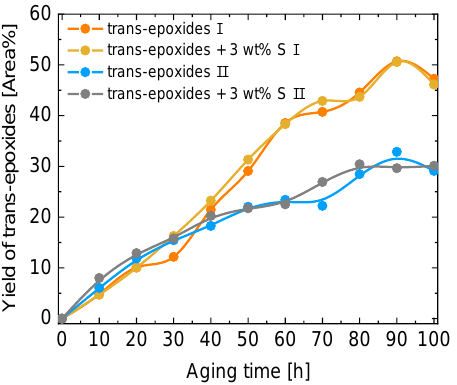
Figure 11. GC–MS measurement to record the yield of trans-epoxide while aging the blends over time. On the one hand, the orange line (C18:1) and the yellow line (C18:1 + 3 wt% S) represent the first measurement. On the other hand, the blue line (C18:1) and silver line (C18:1 + 3 wt% S) depict the repeat measurement ( n = 2). I describes the first, II the second measurement.